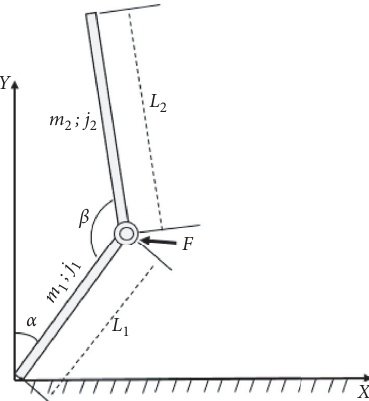
Figure 1: Double inverted pendulum Table 1: Parameters of the double inverted pendulum system.